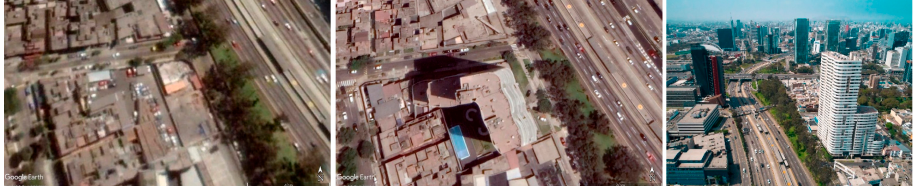
Figure 5. Replacing buildings—Building “LUX” in Lima Center. Satellite image from 2015 ( left ) and 2022 ( center ). Source: Google Earth, Maxar Technologies 2022. Photo of the building LUX in Lima ( right ) and other high buildings in the background. Source: https://edificiolux.com.pe/ (accessed on 5 November